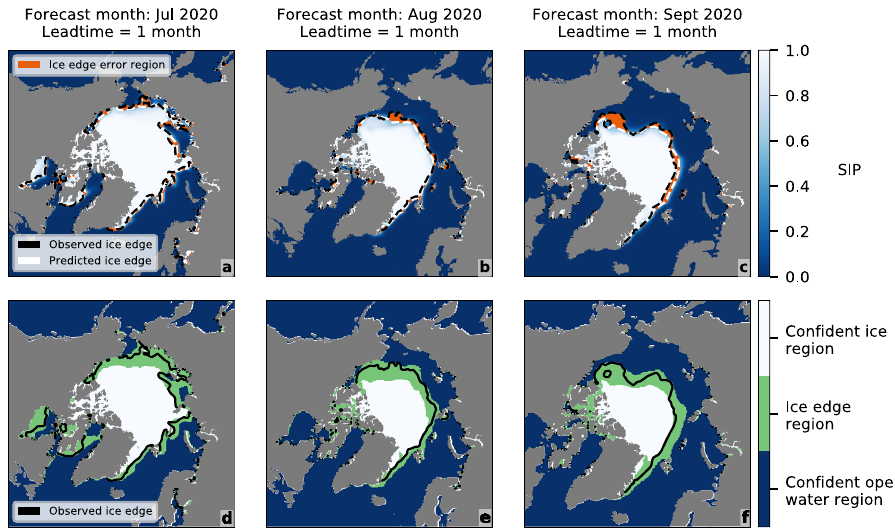
Fig. 7 IceNet ’ s forecasts for July, August, and September 2020 at a 1-month lead time. a – c IceNet ’ s predicted sea ice probability (SIP), p , with binary ice edge errors overlaid. d – f IceNet ’ s predicted ice edge region, corresponding to p ∊ [ p ′ 90% , 1 − p ′ 90%